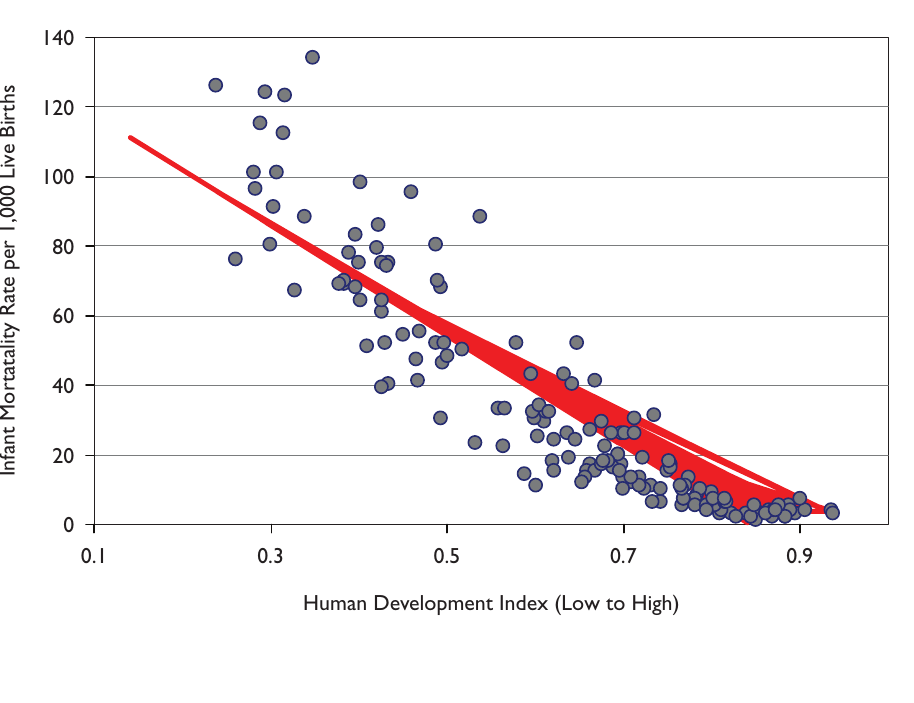
Figure 1. Relationship between Human Development Index and Infant and Maternal Mortality Rates, 167 Countries,